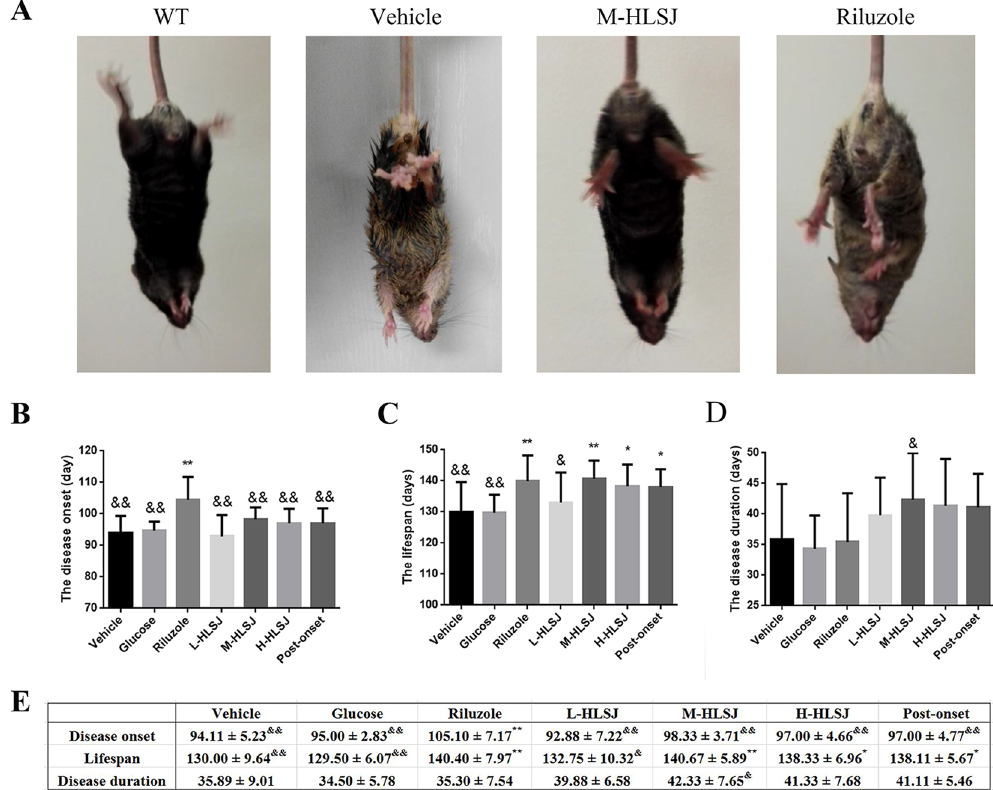
Figure 3. Effects of HLSJ on the phenotype, disease onset, lifespan and disease duration in SOD1 G93A mice. ( A ) The different hind limb clasping phenotypes at the age of 120 days. The comparing results of the ( B ) disease onset, ( C ) lifespan and ( D ) disease onset. ( E ) The detailed data of the disease onset, lifespan and disease onset in 7 groups. Significant differences with vehicle group at * P < 0.05 and ** P < 0.01. Significant differences with riluzole group at & P < 0.05 and && P <